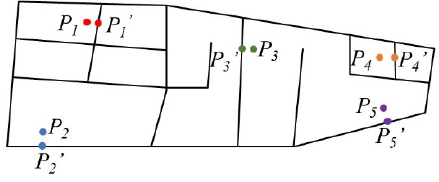
Figure 5. Projection of the points.